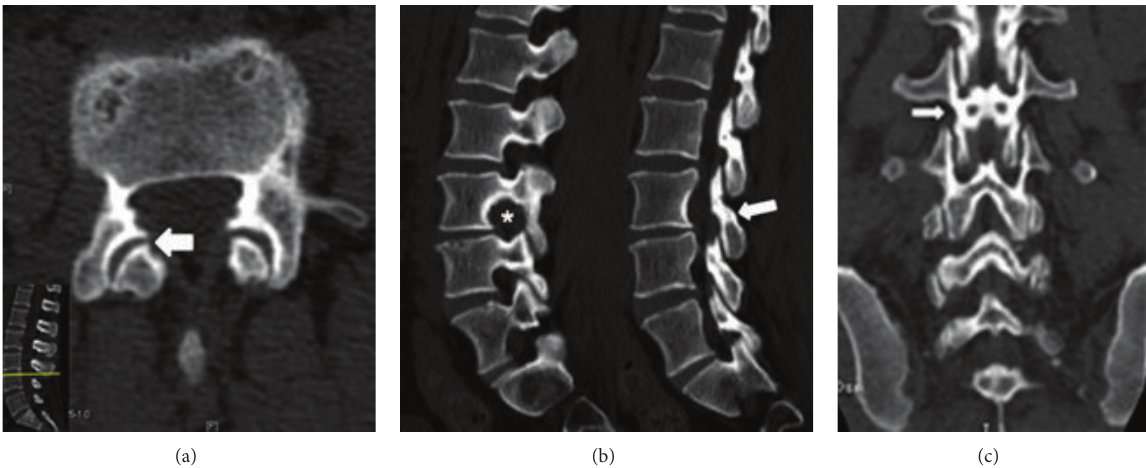
Figure 10: Postoperative bone window CT scan: (a) axial view demonstrating facet joint integrity (arrow); (b) sagittal view showing widening of the neural foramen ( ∗ ) and pars interarticularis sparing (arrow); (c) coronal view also illustrating pars preservation